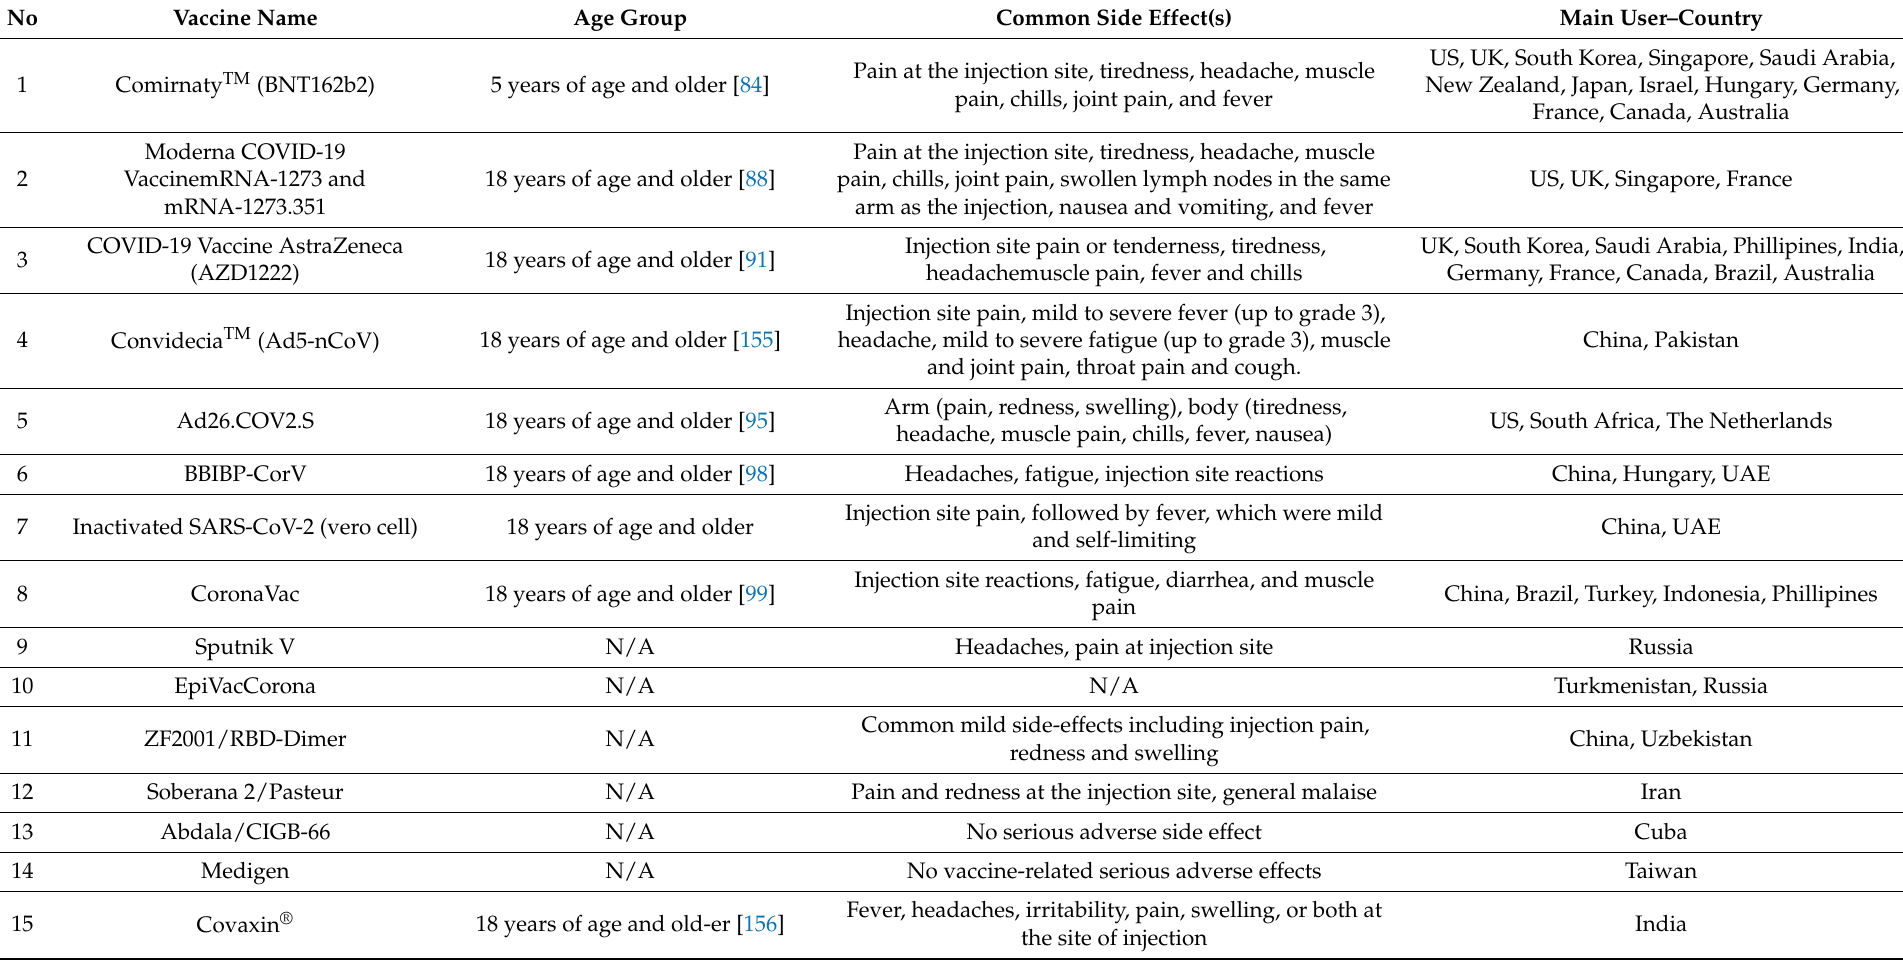
Table A1. More information on authorized/approved vaccines in at least one country as per 15 November